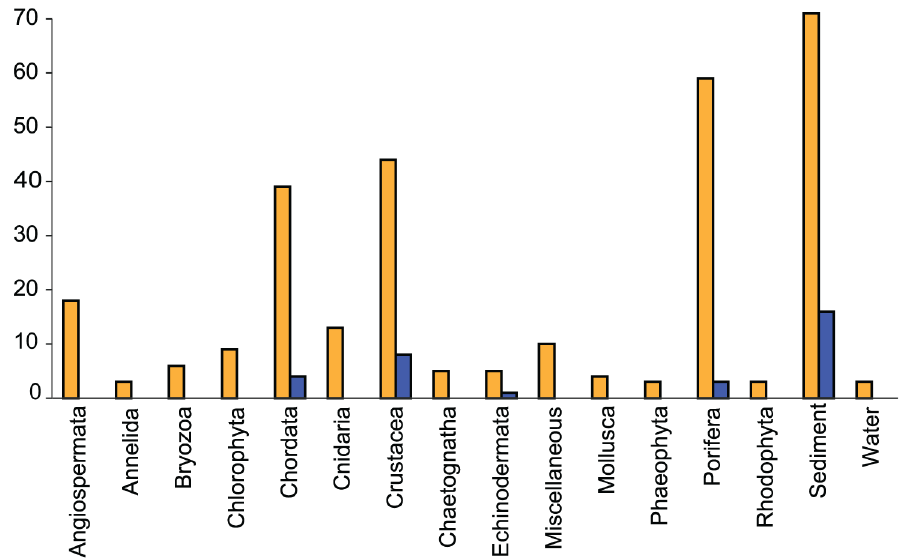
Fig 3. Isolate sources. The number of isolates per source type is shown as orange bars. The number of unknown isolates per source type is shown as blue bars.